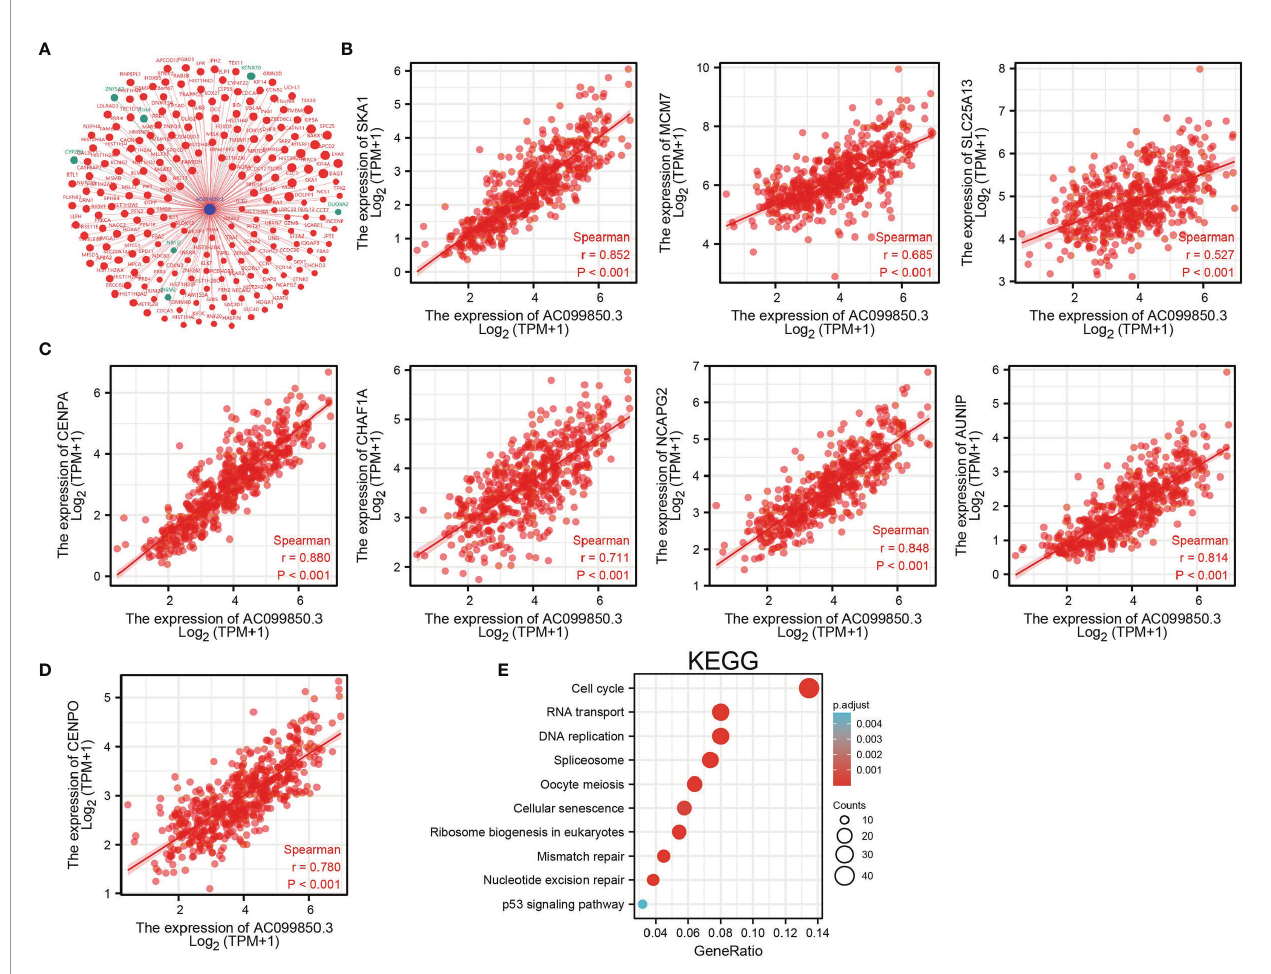
FIGURE 5 | KEGG enrichment analysis of AC099850.3. (A) The gene – gene interaction network of AC099850.3 in LUAD. (B – D) Genes that were signi fi cantly positively correlated with AC099850.3 expression in LUAD based on our TCGA-LUAD data. (E) KEGG enrichment analysis of AC099850.3.in